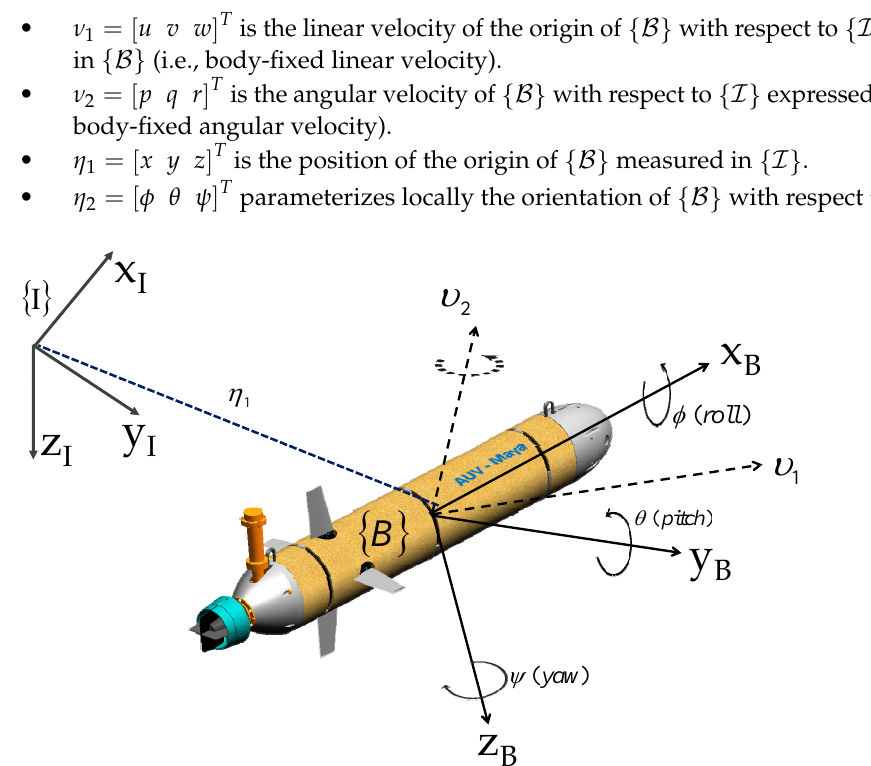
Figure 2. Notations and reference frames for an